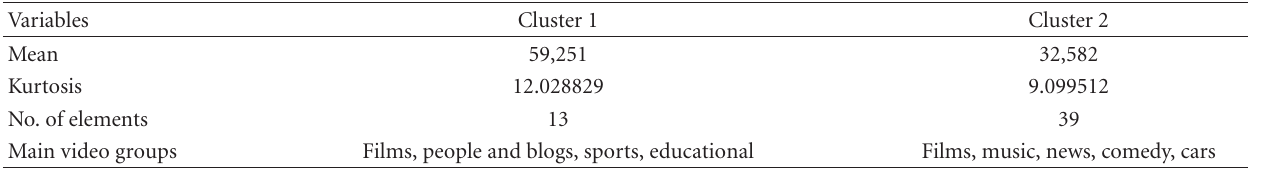
Table 5: Clustering results using k -means